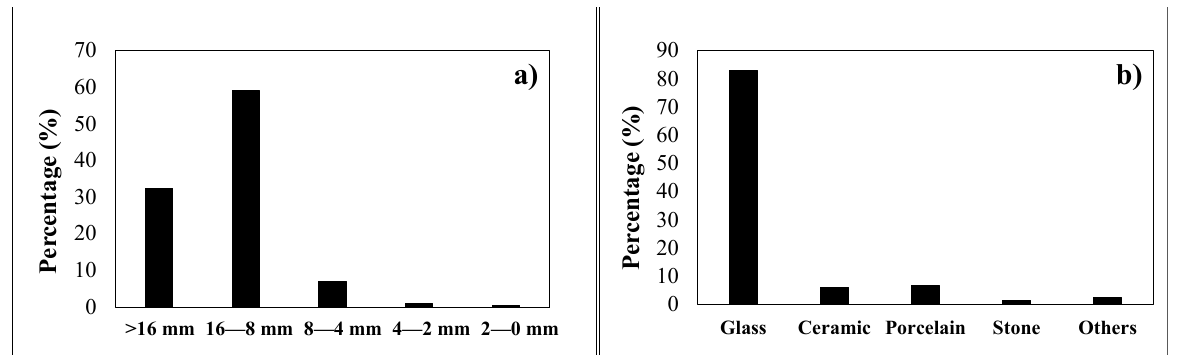
Figure 1. CSP (ceramic, stone, and porcelain) waste as raw material and as an alkali-activated cement (AAC) precursor: ( a ) Particle size distribution in mass percentage; ( b ) CSP composition (wt %).